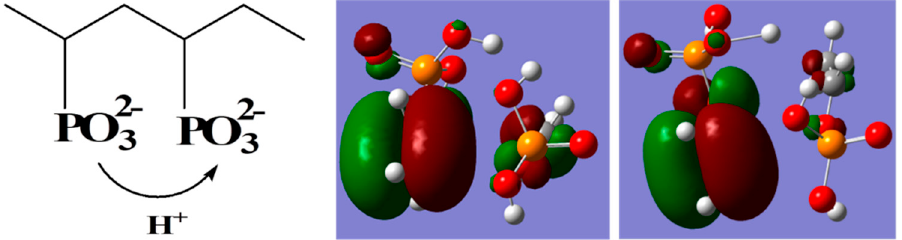
Figure 11. A visual presentation of proton migration along phosphate groups based on distance analysis. Shown on the right-hand side is the DFT computation result of the protonated and deprotonated vinyl phosphates, in qualitative agreement with the molecular dynamics simulation